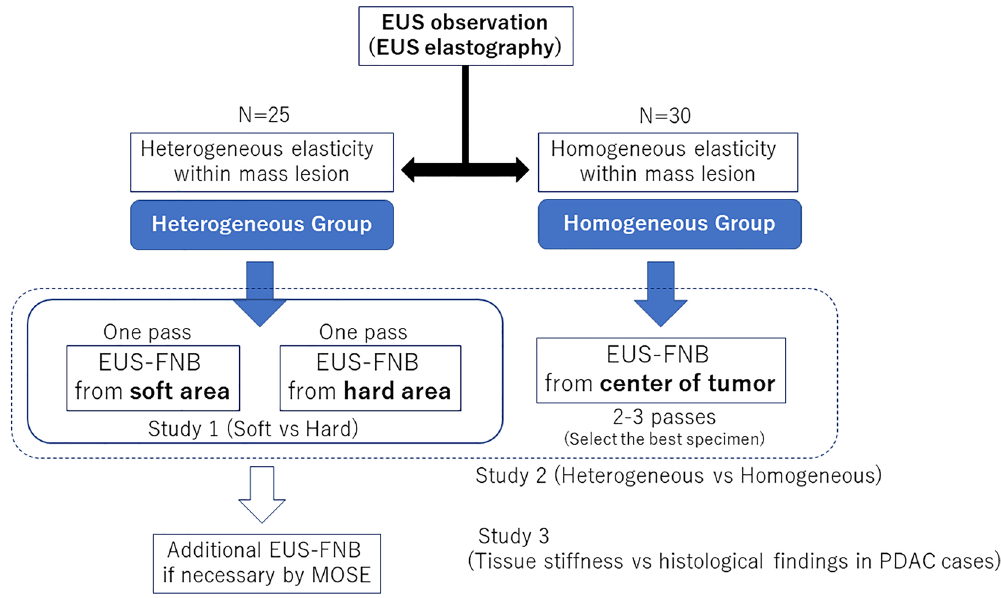
Figure 1. Flow diagram of study participants.